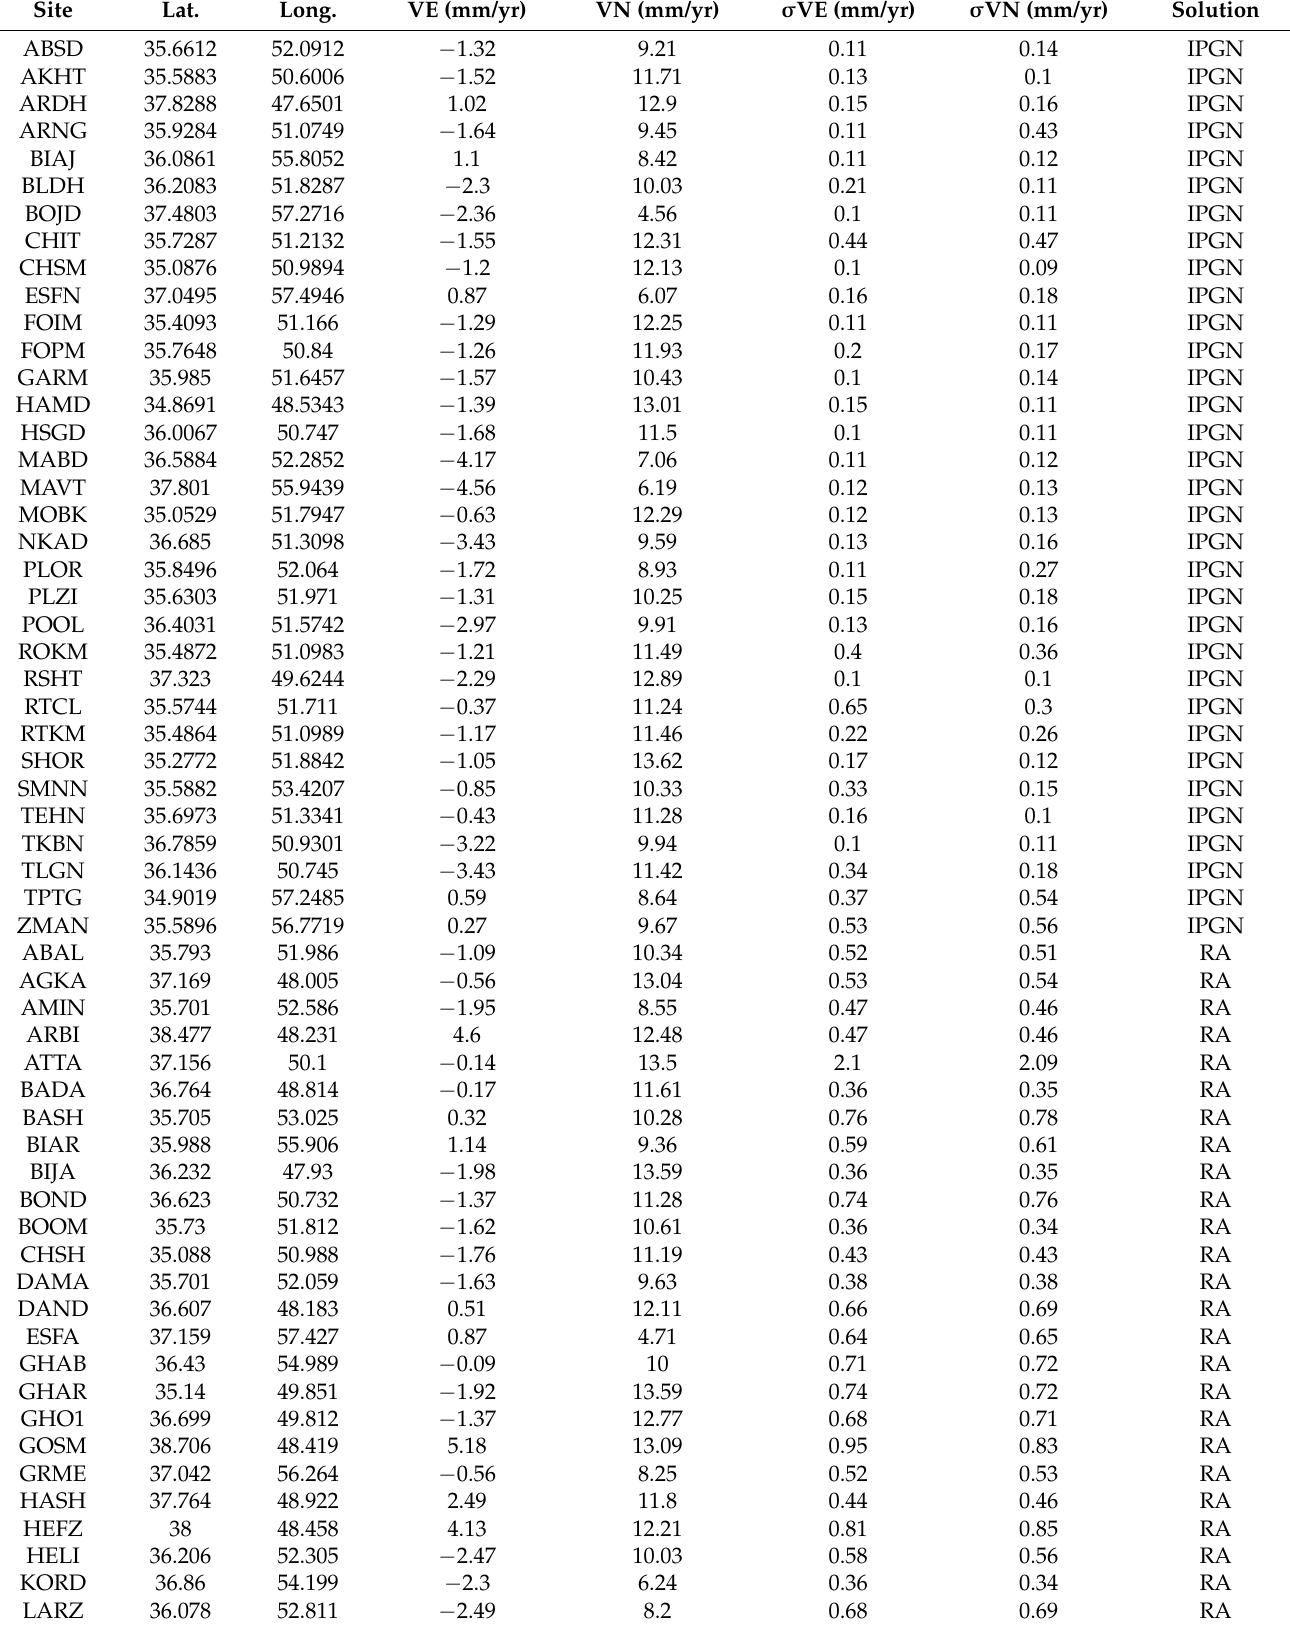
Table 5. The GPS velocities used in this paper which are relative to Eurasian reference frame